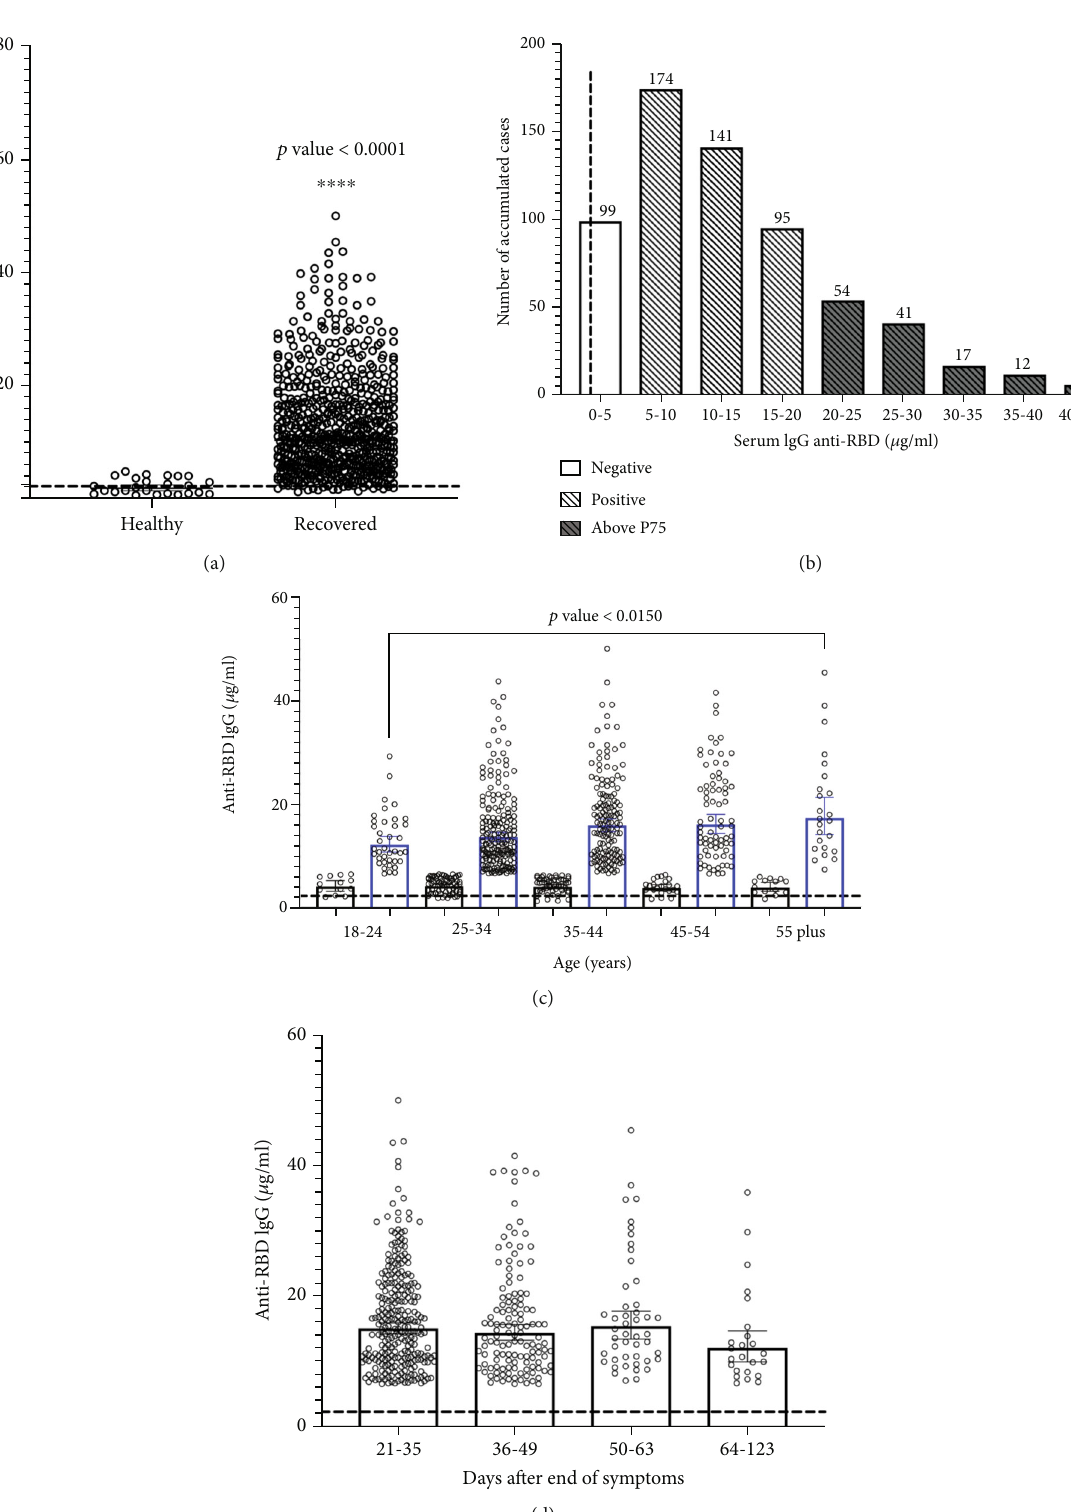
Figure 1: Analysis of anti-RBD IgG in individuals exposed to SARS-CoV-2 in the metropolitan region of Chile. (a) Anti-RBD IgG levels in participants, namely, healthy controls as the baseline group ( N = 25 ), and participants who recovered from COVID-19 with di ff erent days of convalescence ( N = 639 ). (b) Histogram for accumulated frequency and antibody concentration range. Positive and negative ELISA results are indicated. Darker bars represent the 75th percentile (P75) for the studied cohort. (c) Anti-RBD levels based on age for positive (blue bars) and negative (black bars) cases. (d) Levels of IgG after symptom o ff set in the convalescent group and positive qualitative ELISA. (a – d) In all cases, the dashed line corresponds to the healthy